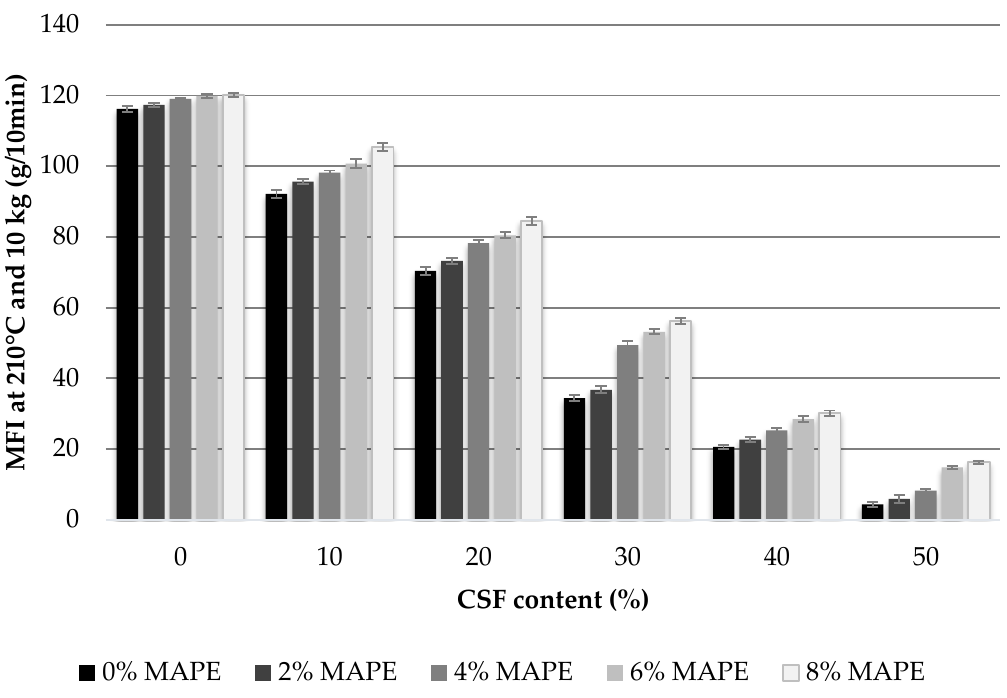
Figure 2. Melt Flow Index of Bio-polyethylene (BioPE) and Bio-polyethylene with corn stover fibers (BioPE/CSF) coupled and uncoupled composites.